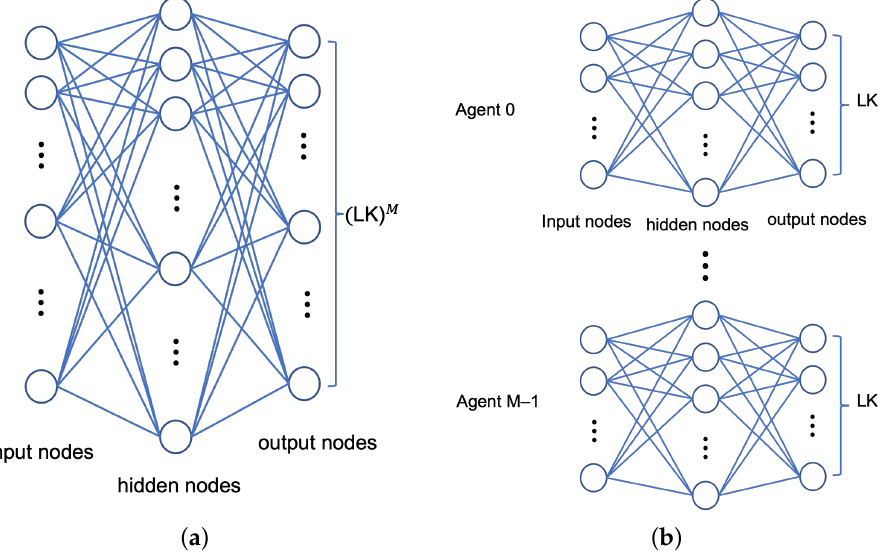
Figure 3. Structure of artificial neural network (ANN) implemented in DQN. ( a ) Joint DQN, ( b ) Multi- agent